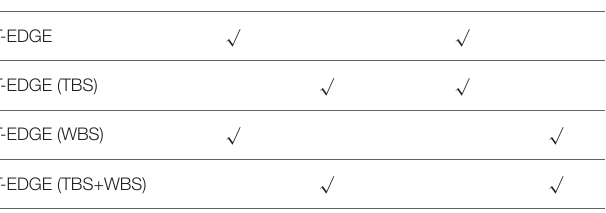
TABLE 1 | Four types of T-EDGE variation for the Ethereum transaction network.